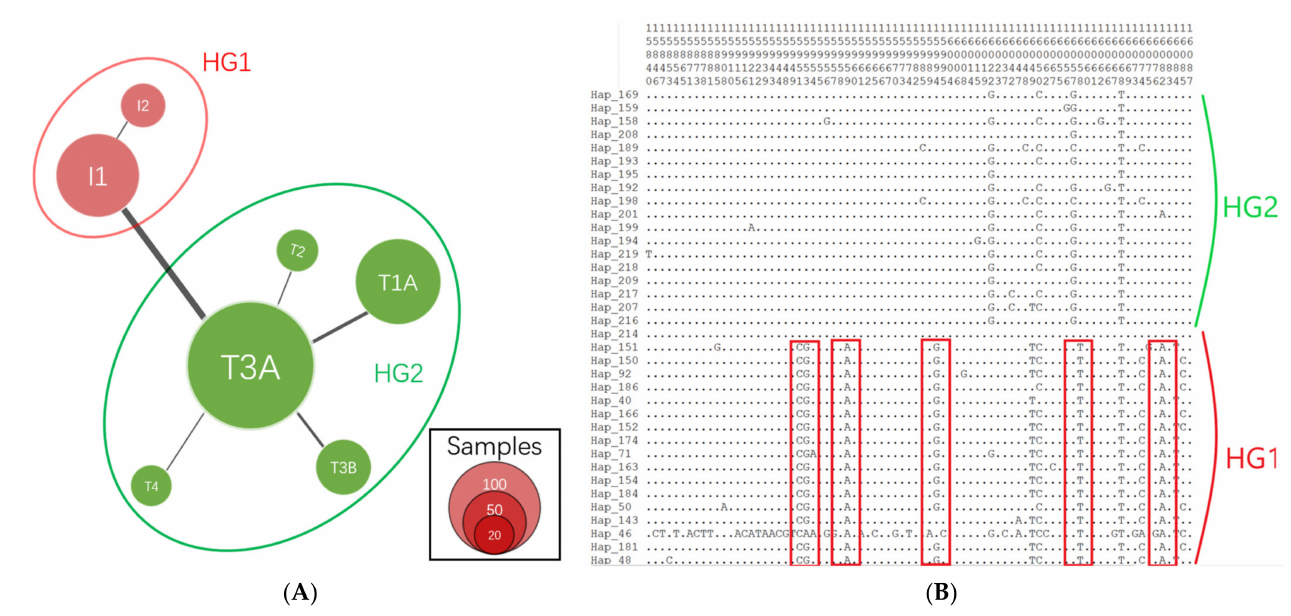
Figure 1. Haplogroups and distinctive mutations in Chinese Holstein cows. ( A ) Median-joining (MJ) network of haplotypes in Chinese Holstein cows. The size of circle represents the number of individ- uals in this haplotype. Black lines within the branches represent different genetic distance between haplotypes. ( B ) The distinctive polymorphism sites (a portion of all sites) between two haplogroups. Polymorphism sits encircled by red boxes are crucial variants distinguishing two haplogroups (red, HG1; green, HG2). The numbers in each site (top) represent the genomic coordinates in